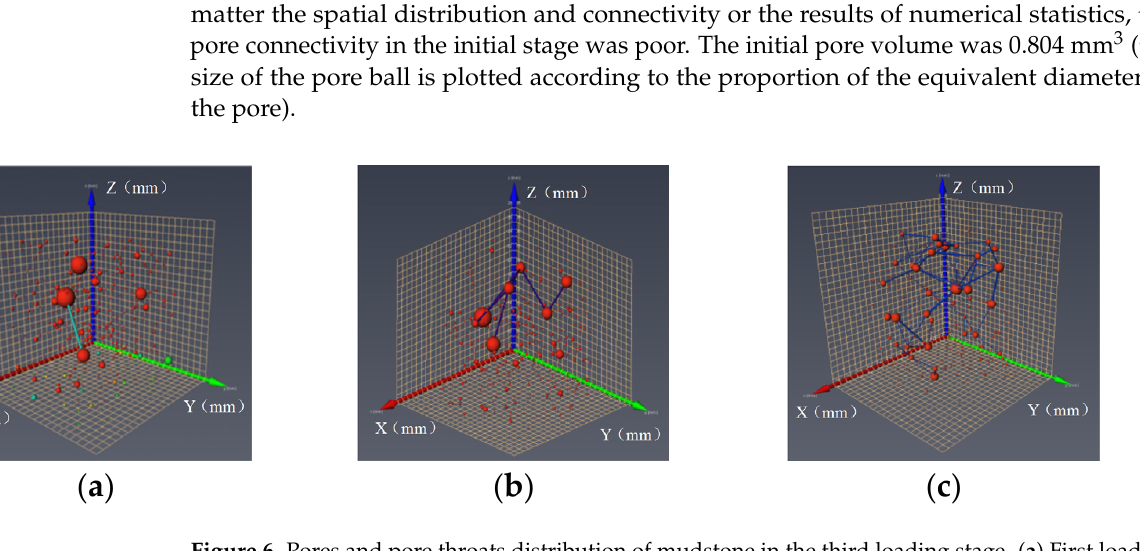
Figure 7. Complete failure result of mudstone and 3D image of fractures.